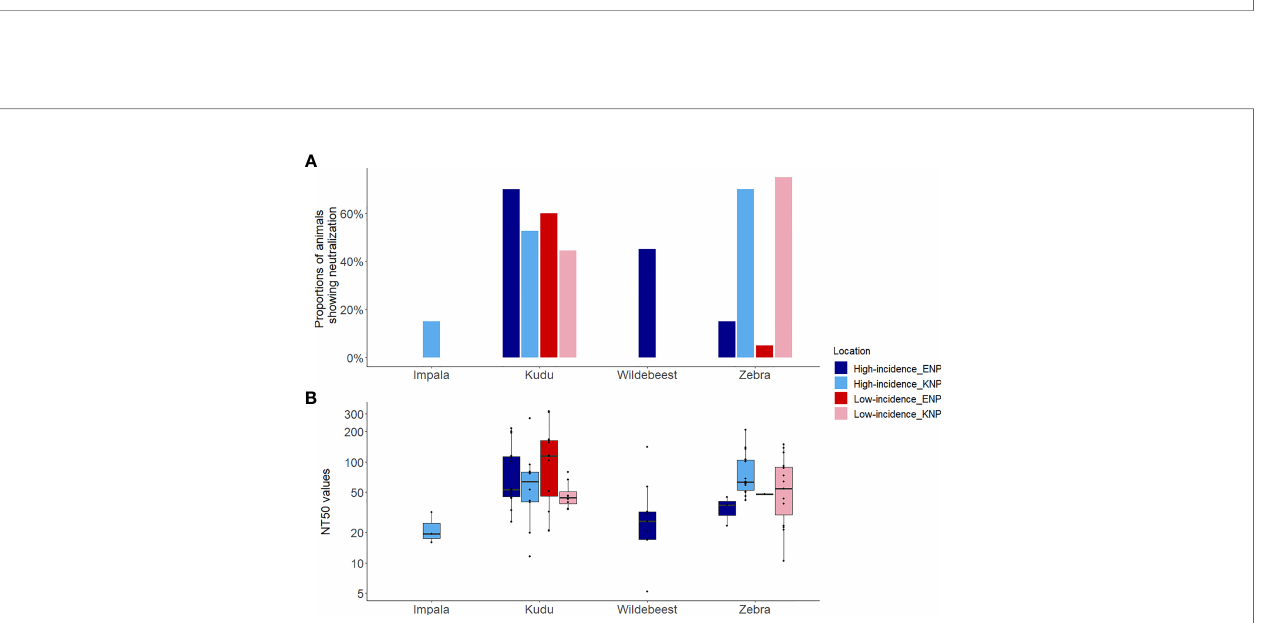
FIGURE 5 | Host toxin neutralization against the Bacillus anthracis lethal toxin for four wild herbivore species sampled in Kruger National Park (KNP), South Africa, and Etosha National Park (ENP), Namibia, showing (A) the proportion of animals showing neutralization, and (B) the neutralization titre 50 (NT 50 ). The NT 50 was the highest titre that protected 50% of mouse macrophage cells. The y-axis of plot (B) represents log10 transformed NT 50 . Species of study included greater kudu ( Tragelaphus strepsiceros ), plains zebra ( Equus quagga ), impala ( Aepyceros melampus ), and blue wildebeest ( Connochaetes taurinus ). The locations of high and low incidence areas in each park are shown in Figure 1